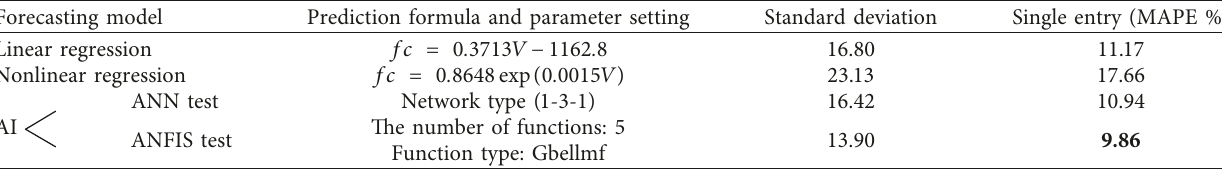
Table 6: Comparison of ANFIS, ANN, linear, and nonlinear regression model prediction accuracy.